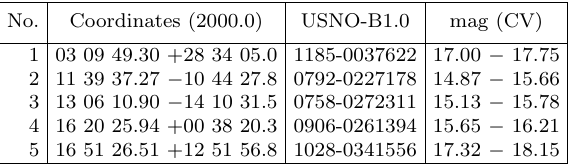
Fig. 4. The light curves of RRC stars with a single non-radial pulsation. Left-hand column of panels: raw data with the (cid:12)rst overtone period; three right-hand columns of panels: the folded light curves with the other oscillation pre-whitened. Table 1. Equidistant triplets: positions and magnitudes.